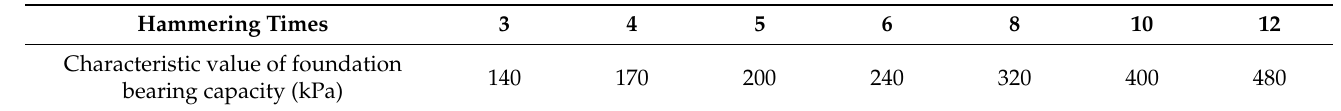
Table 3. The characteristic value of the bearing capacity of the gravel soil foundation determined by the heavy-duty dynamic penetration number N63.5.